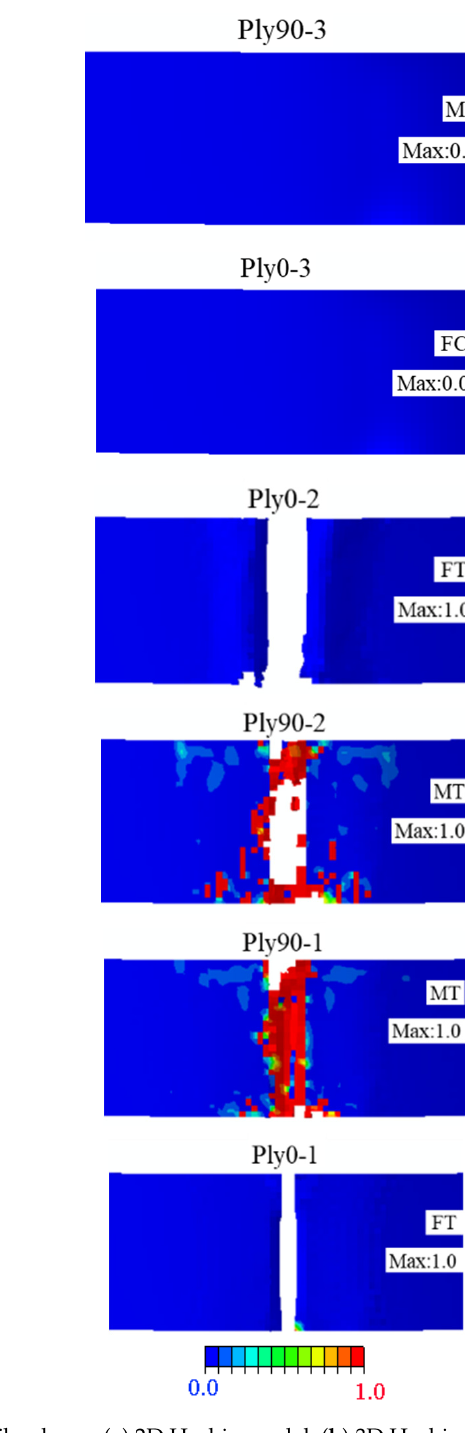
Figure 20. Damage patterns of the carbon fibre layer: ( a ) 2D Hashin model; ( b ) 3D Hashin model.